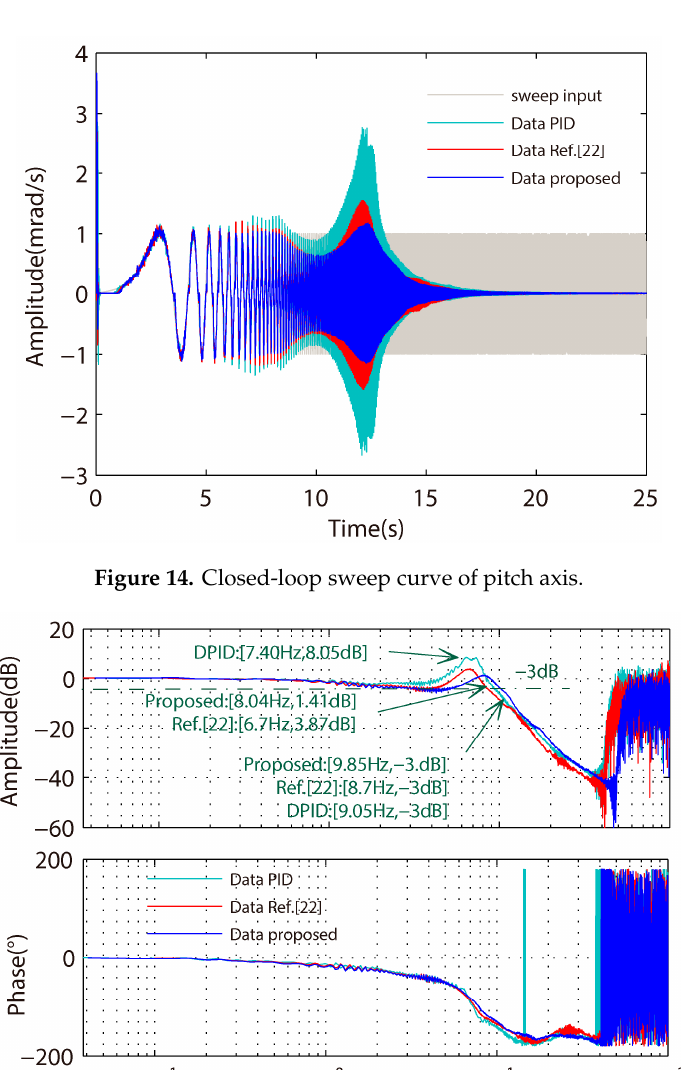
Figure 13. Absolute value of sinusoidal guidance error curve.